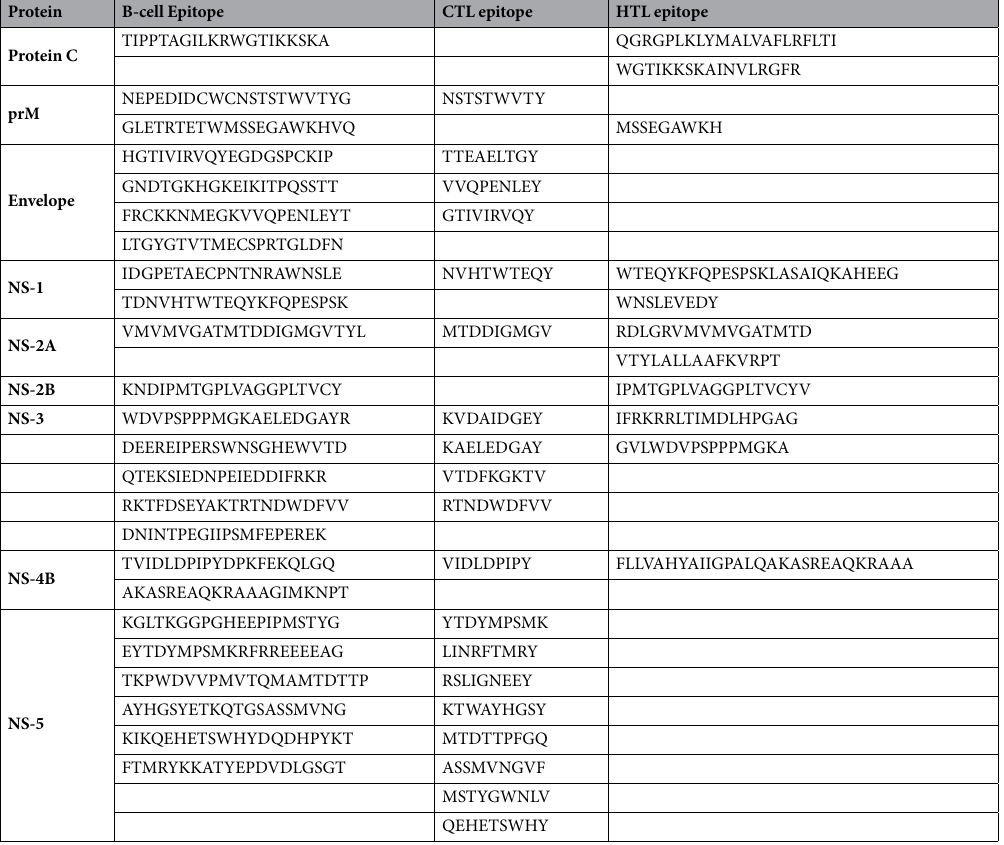
Table 1. Selected CTL and HTL epitopes overlapping with B-cell epitopes.